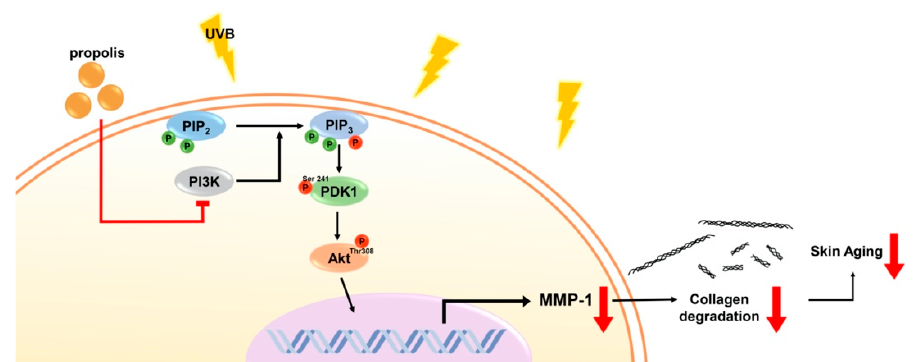
Figure 7. Schematic diagram summarizing the molecular mechanism of propolis. PIP 2 , Phosphatidylinositol 4,5-bisphosphate; PIP 3 , Phosphatidylinositol (3,4,5)-trisphosphate; PI3K, phosphoinositide 3-kinase; PDK1, phosphoinositide-dependent protein kinase-1; Akt, protein kinase B; MMP-1, matrix metalloproteinase-1.